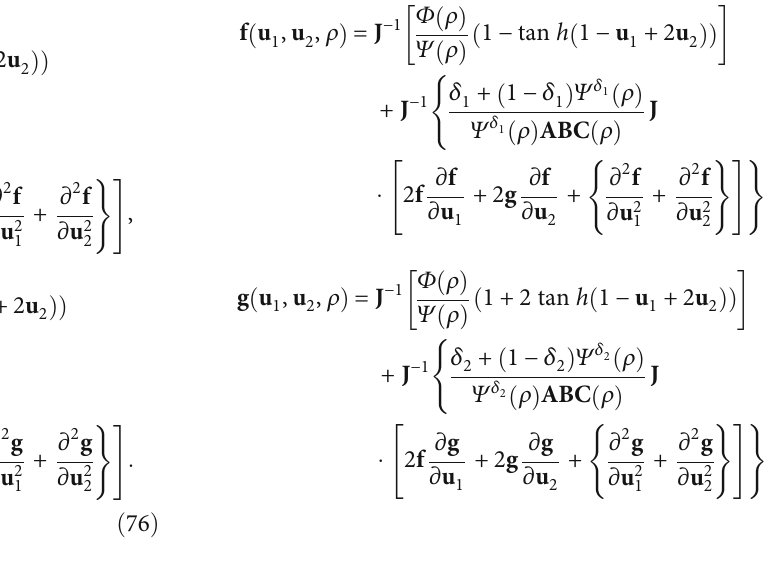
JTDM C , and ABC of Example 16 for estimated solutions of f ð u 1